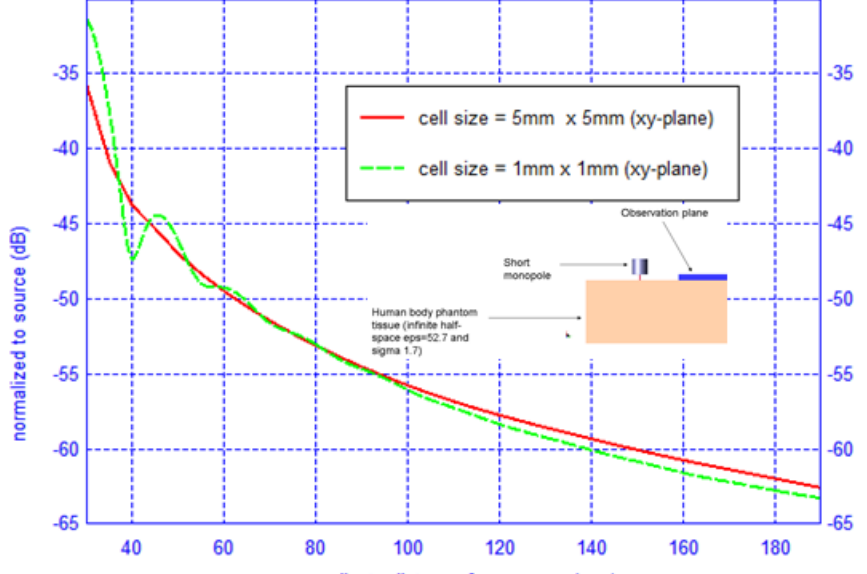
Figure 11. Experiment to determine if the down-sampled human body voxel set causes numerical inaccuracies ( λ = 10 cm